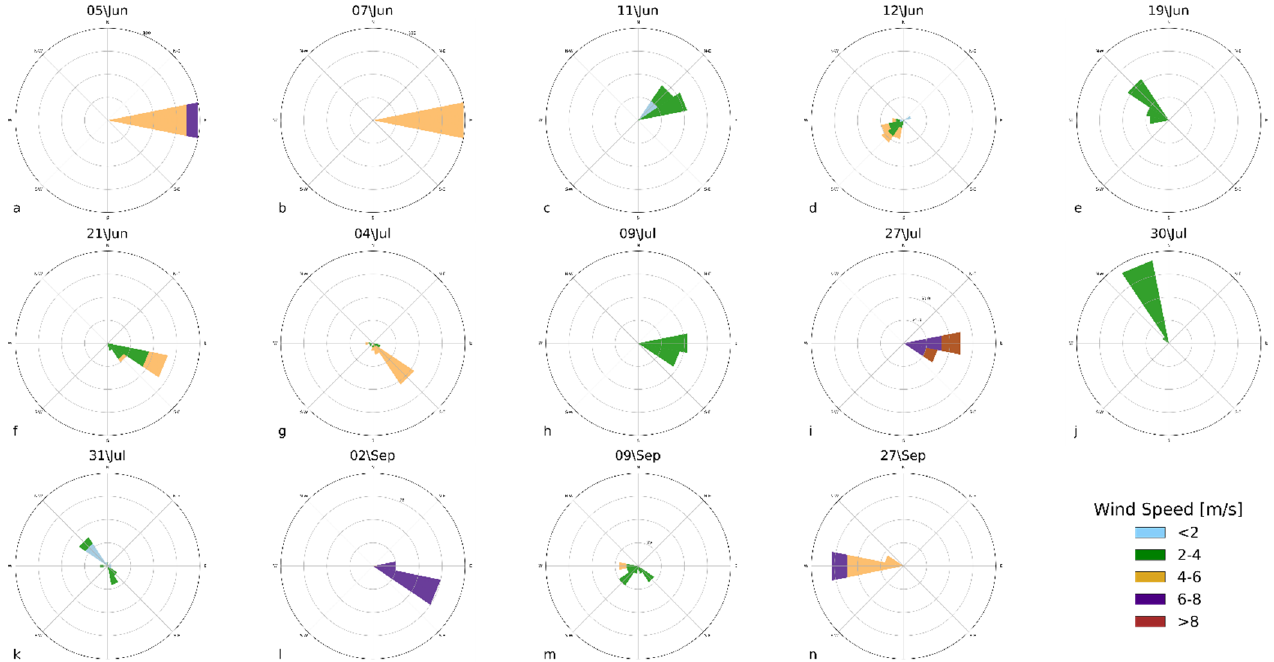
Figure A1. RGB composites of the satellite imagery similar to Figure 2. Figures a – f depict the ice break-up with increased turbidity. During mid-Summer (Figures g – n ), turbidity is decreased with